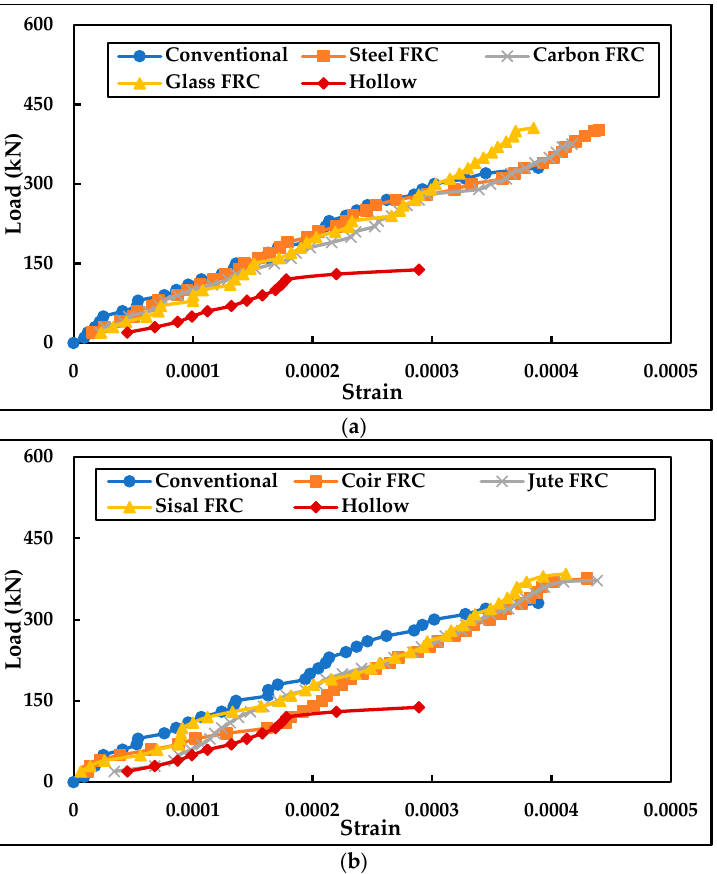
Figure 11. Graphical illustration of load vs. strain. ( a ) Artificial FRC. ( b ) Natural FRC. The axial shortening of the columns with carbon, coir, and jute FRC infills was also observed to be less than that of columns with other types of fibre-reinforced concrete in- fills. Contrasting the use of conventional concrete and steel tube columns filled with steel, carbon, and glass fibre-reinforced concrete, the percentage decrease in axial shortening was found to be 4.15, 8.39, and 2.25, respectively. Comparing coir, jute, and sisal FRC- infilled steel tubular columns to conventional CFST columns, the percentage reduction in axial shortening was found to be 15.19%, 12.62%, and 4.98%, respectively. Figure 12 illus- trates the relationship between load and axial shortening for hollow stub columns and stub columns with different kinds of concrete infills. According to Figure 13, localized buckling and crushing of the infilled concrete at the bottom of the column contributed to the column’s failure.